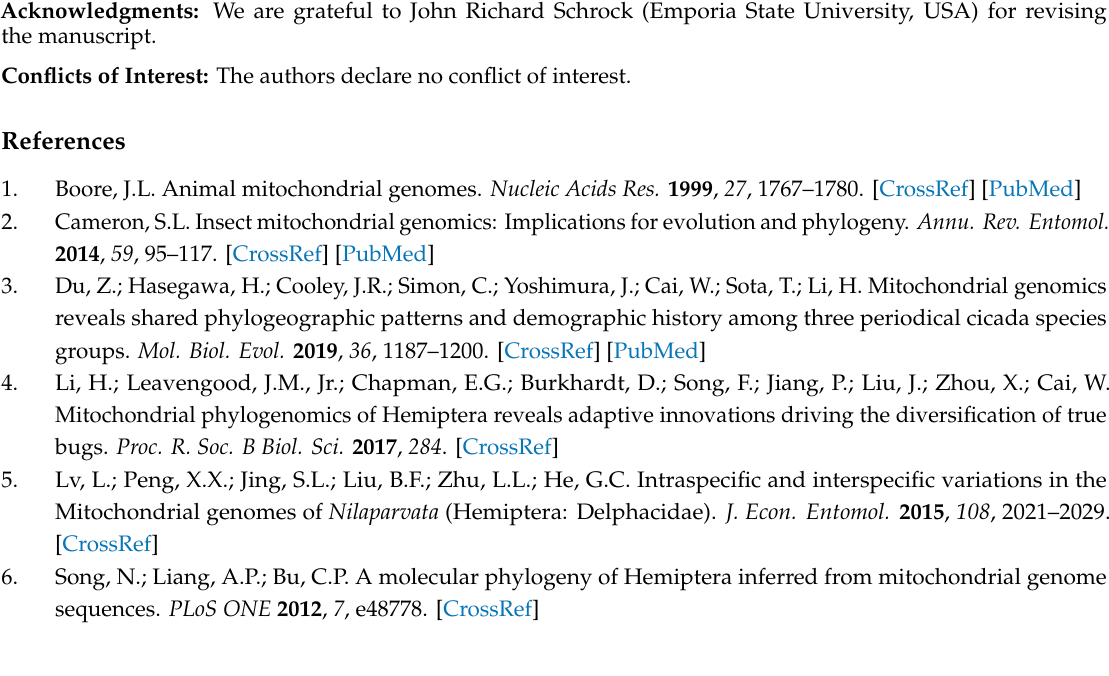
Table S1. Collection information of the Ledrinae species sequenced in present study. Table S2. Best partitioning schemes and models based on di ff erent datasets for Bayesian inference (BI) analysis. Table S3. Best partitioning schemes and models based on di ff erent datasets for maximum likelihood (ML)